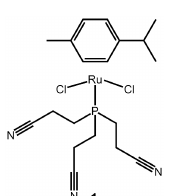
Figure 1. The molecular structure of 1 showing atom labelling and displacement ellipsoids at the 70%